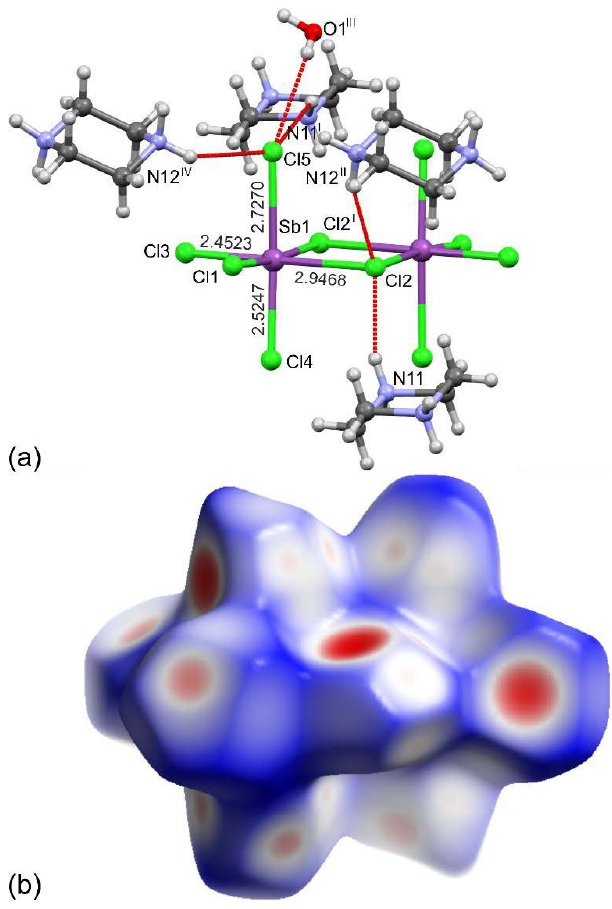
Figure 2. The N / O–H ··· Cl hydrogen bonds represented by the broken red lines to Cl2 and Cl5 atoms ( a ) along with the corresponding Hirshfeld surface mapped with d norm for the [Sb 2 Cl 10 ] 4− bioctahedral unit ( b ) in 1 at 85 K. The overlapping surfaces are marked in red, touching in white, whereas separated in navy blue ( b ). Symmetry codes: (I) – x + 1, – y + 1, – z ; (II) x – 1/2, – y + 3/2, z – 1/2; (III) x – 1/2, – y + 1/2, z – 1/2; (IV) – x + 1/2, y – 1/2, – z + 1/2. Table 4. Residual δ charges on the X atoms for 1 (X = Cl) and 2 (X = Br) at 295 and 85